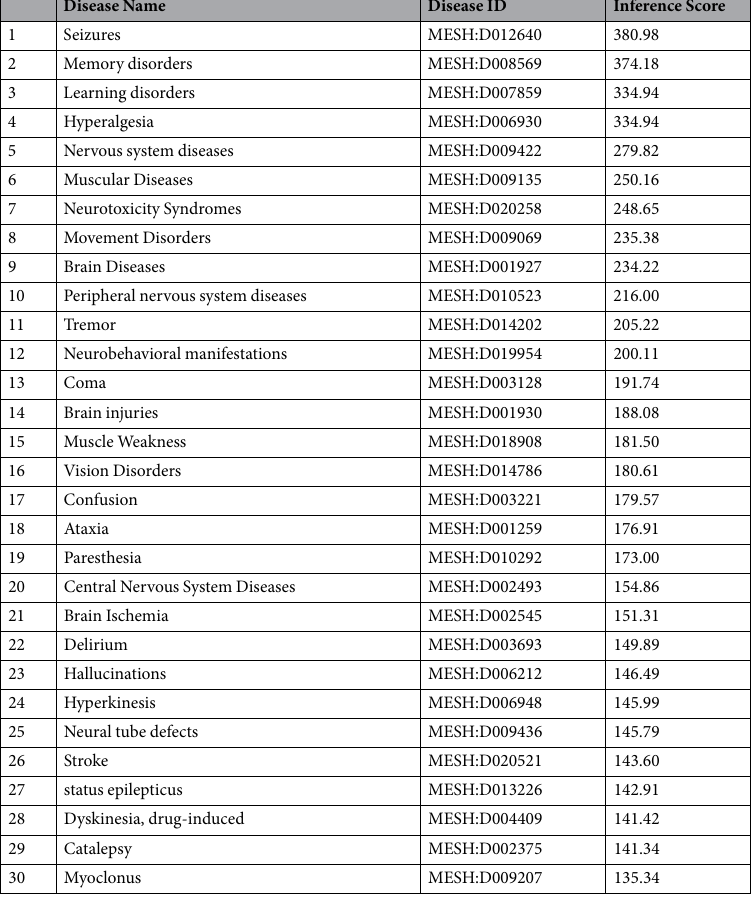
Table 5. Top nervous system diseases associated with tumor necrosis factor (TNF) from the Comparative Toxicogenomics Database